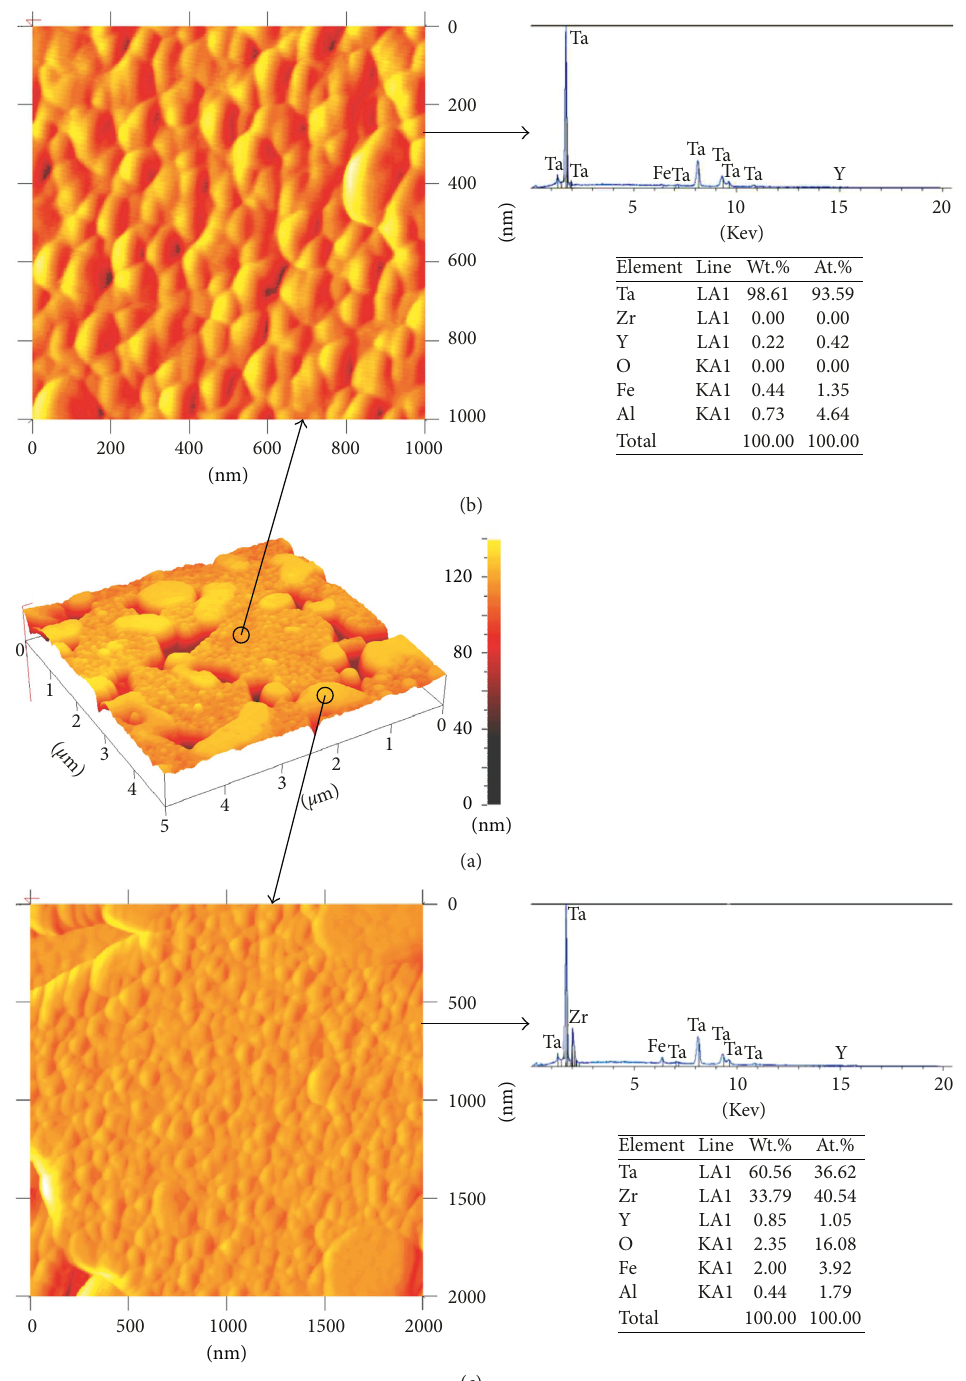
2 nanocomposite: